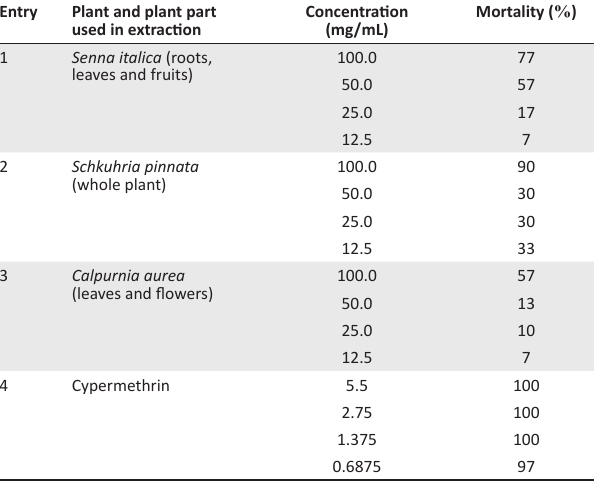
TABLE 2: Dose-dependent mortality of the acetone extracts against adult ticks of Rhipicephalus turanicus . Entry